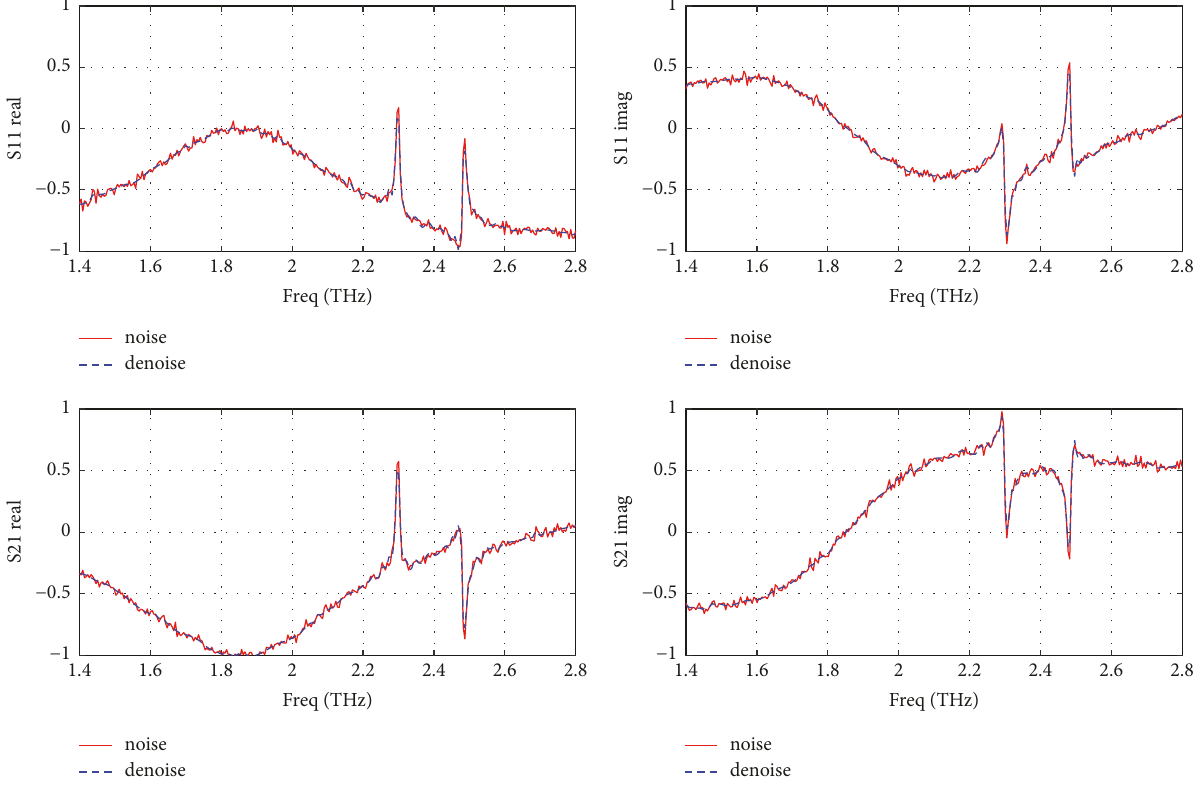
Figure 11: The S11 and S21 results of the photonic